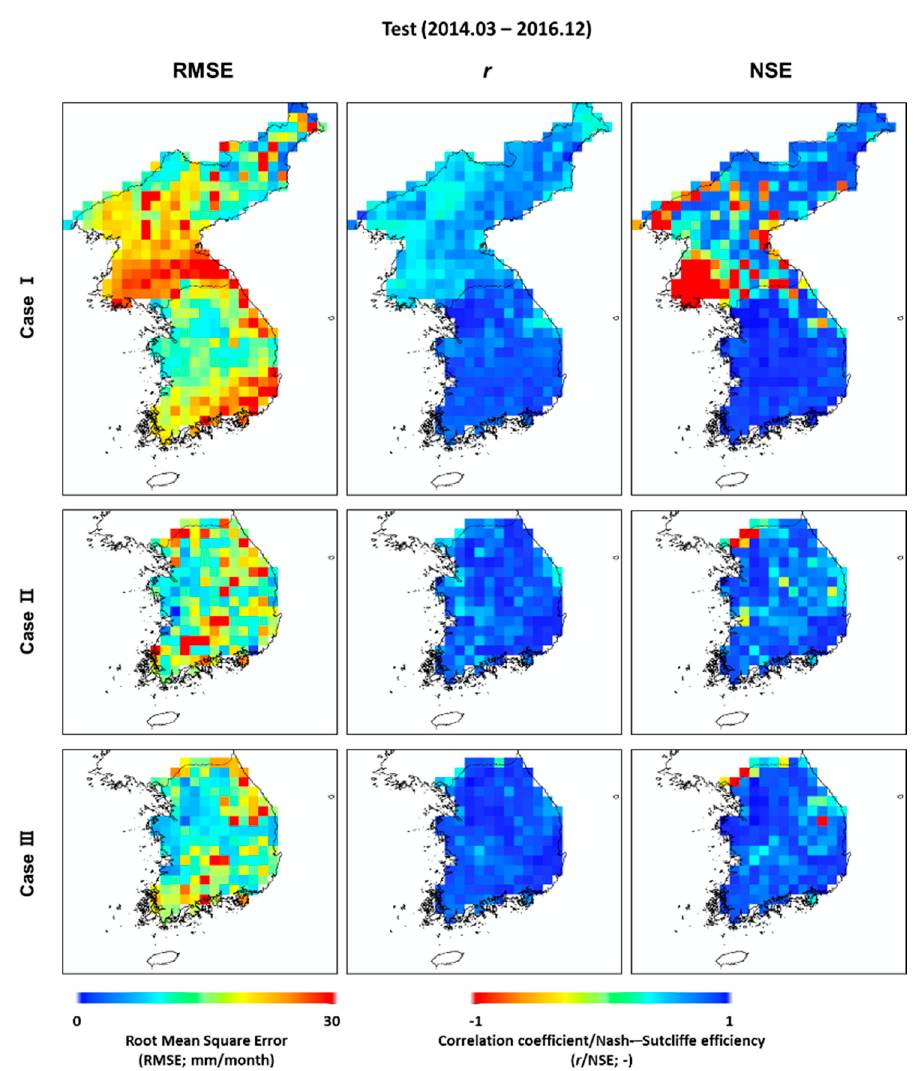
Figure 7. Spatial distribution of the RMSE, correlation coefficient ( r ), and NSE between the ANN-predicted total discharge and target data during the test period (March 2014-December 2016).